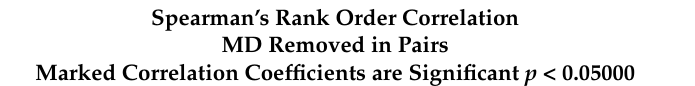
Table 9. Correlation coefficients among serum levels of interleukins and results of personality tests—the control group (statistically significant results marked with red